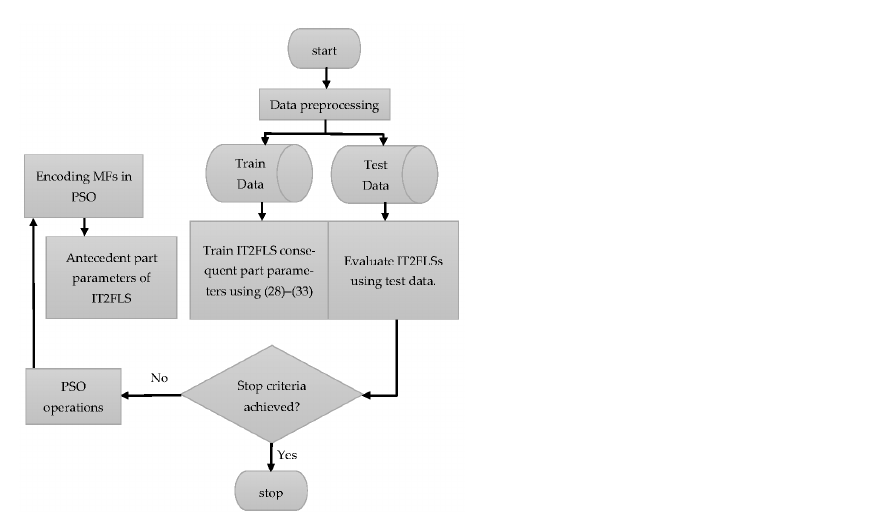
Figure 5. Flowchar of the proposed training method for IT2FLS for calibration.